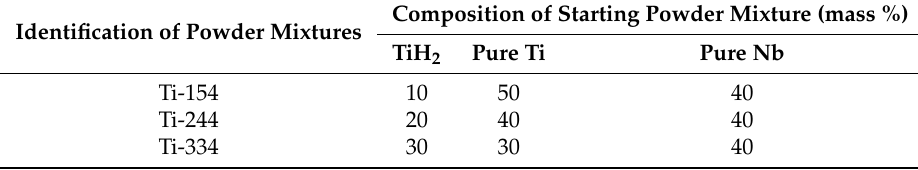
Table 1. Various compositions of the initial powder